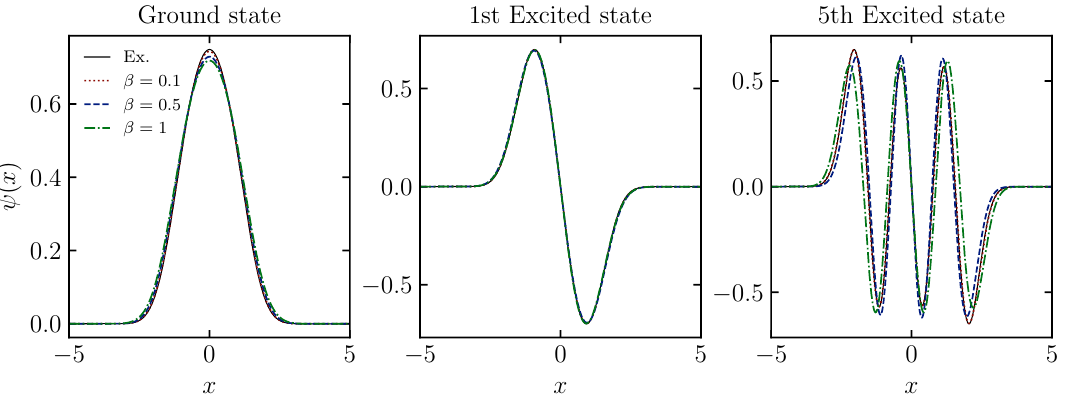
Figure 2: Comparison of the classical eigenstates obtained from the Gibbs dis- tribution and quantum eigenstates obtained solving the stationary Schrödinger equation for the quartic potential V ( x ) = ν x 4 / 4 . States are shown at various β = 0.1,0.5,1. Other parameters: m = 1, ε = ħ h = 1, ν =